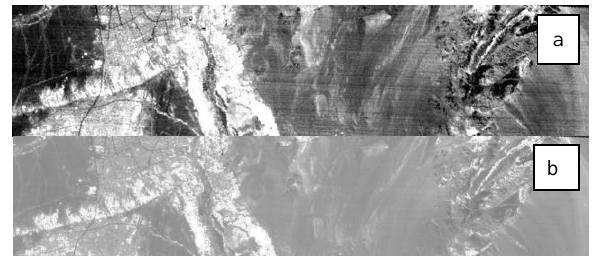
Figure 7. Destriping analysis for Hyperion image: a) before and b) after Striping Removal